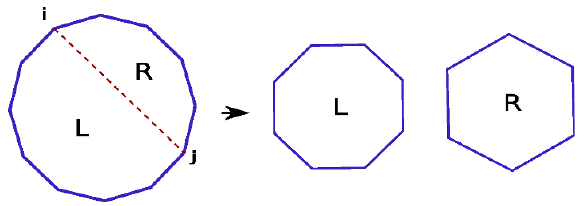
Figure 1 . A dual polygon breaks into two smaller polygons when a (cid:30) 4 propagator is taken on-shell. In this example, a 12-gon breaks into an octagon and a